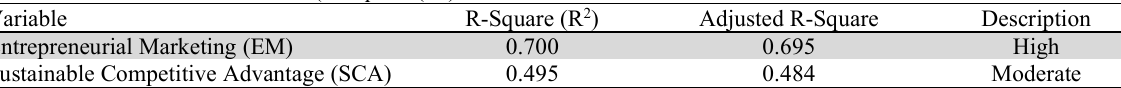
Value of Determination Coefficient (R-Square (R 2 )